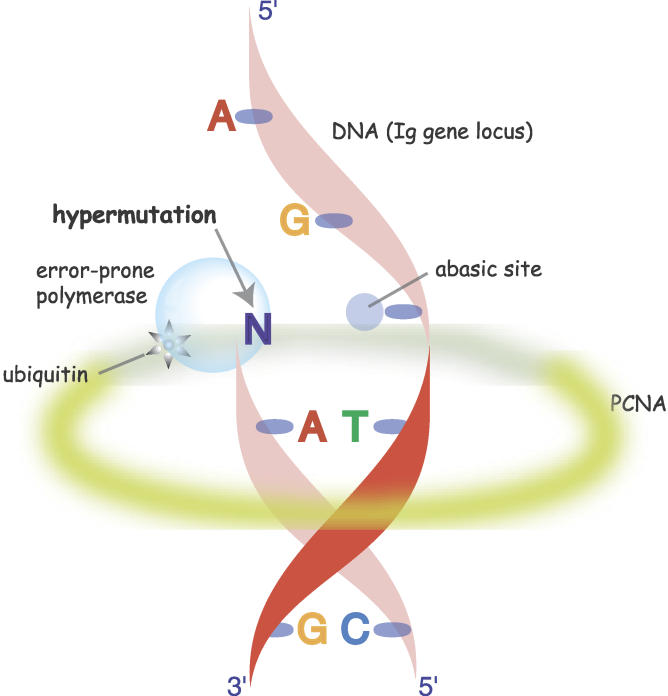
The authors show that vertebrates exploit the PCNA-ubiquitin pathway—a DNA repair pathway—for immunoglobulin hypermutation, most likely through the recruitment of error-prone DNA polymerases.